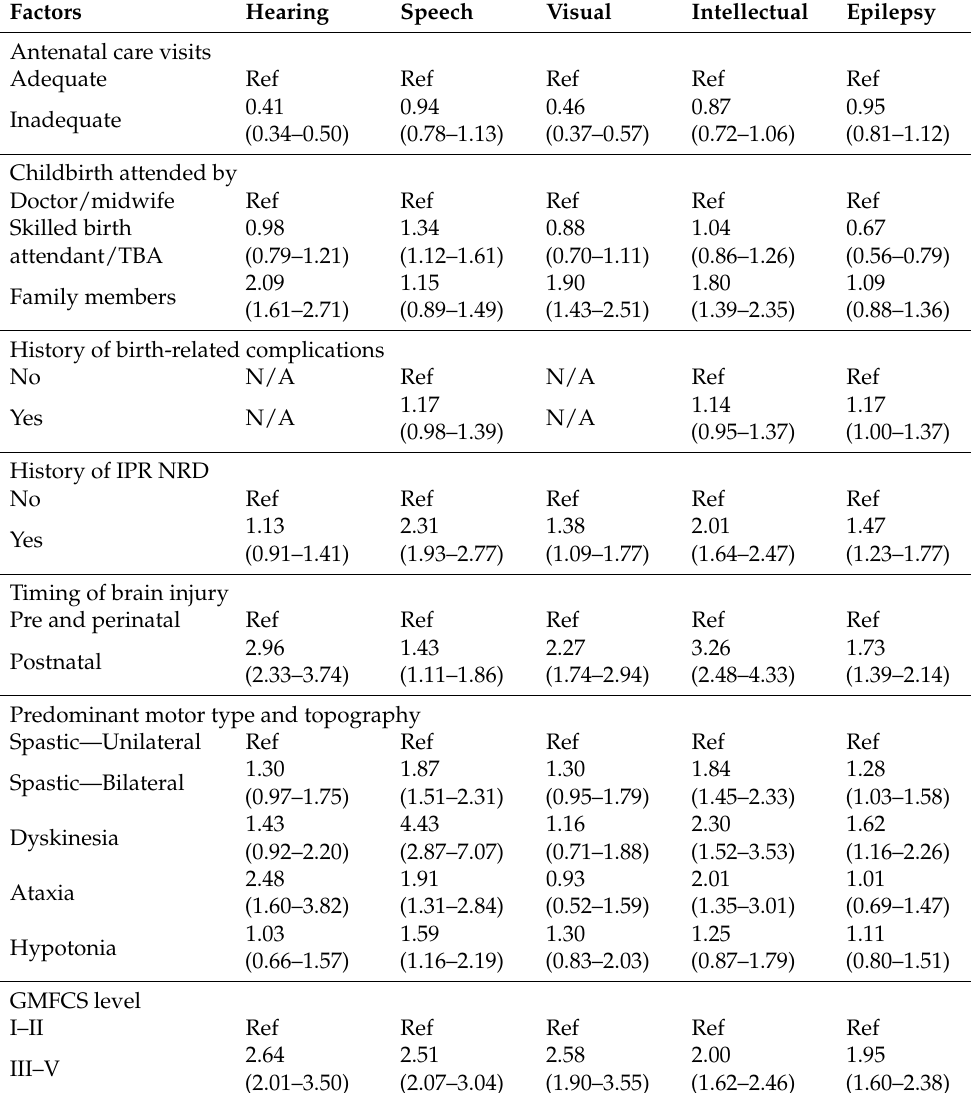
Table 3. Predictors of associated impairments among children with CP in rural